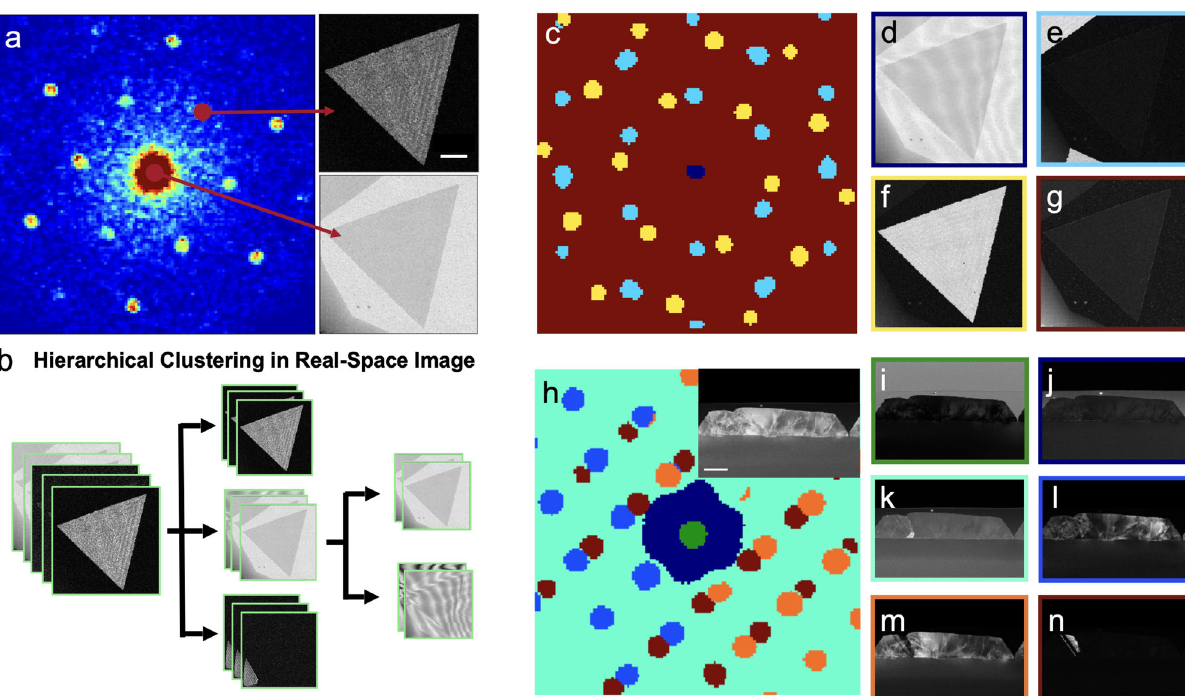
Fig. 5 Clustering results on real space images in 4D-STEM datasets. a Visualizing 4D data in a momentum-major order, where each pixel in diffraction pattern can be considered as a real-space image. Scale bar, 500 nm. b Schematic of the divisive hierarchical clustering architecture on real space images. c Map of hierarchical clustering results in diffraction space on a WS 2 – WSe 2 superlattice. d – g Mean real-space images of the superlattice in each cluster. d Displays the image from dark blue area in ( c ), which represents a virtual BF image; e , f are the images from light blue and yellow portions in ( c ), corresponding to DF images for different fl akes. g Sums all other areas in ( c ), indicating a thickness variation in the sample. h Map of hierarchical clustering results in diffraction space on a cross-sectional InGaP/GaAs crystal, with an ADF image displayed in the inset. Scale bar, 200 nm. i – n Mean real-space images of the sample in each cluster. i corresponds to the center beam, the green area in ( h ), and shows a virtual BF image; j , k are from the dark blue and cyan area in respect, which are from the amorphous carbon and thickness effect in the sample; l – n are virtual DF images for the cross-section, showing strain effects and twin